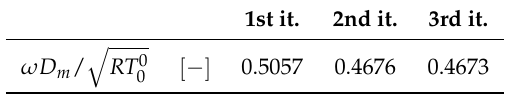
Figure 11. ( a ) Stator and ( b ) rotor blade shapes at different iterations. Table 5. Non-dimensional rotational speed at different